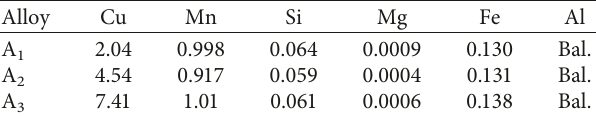
Table 1: Chemical composition of the studied alloys